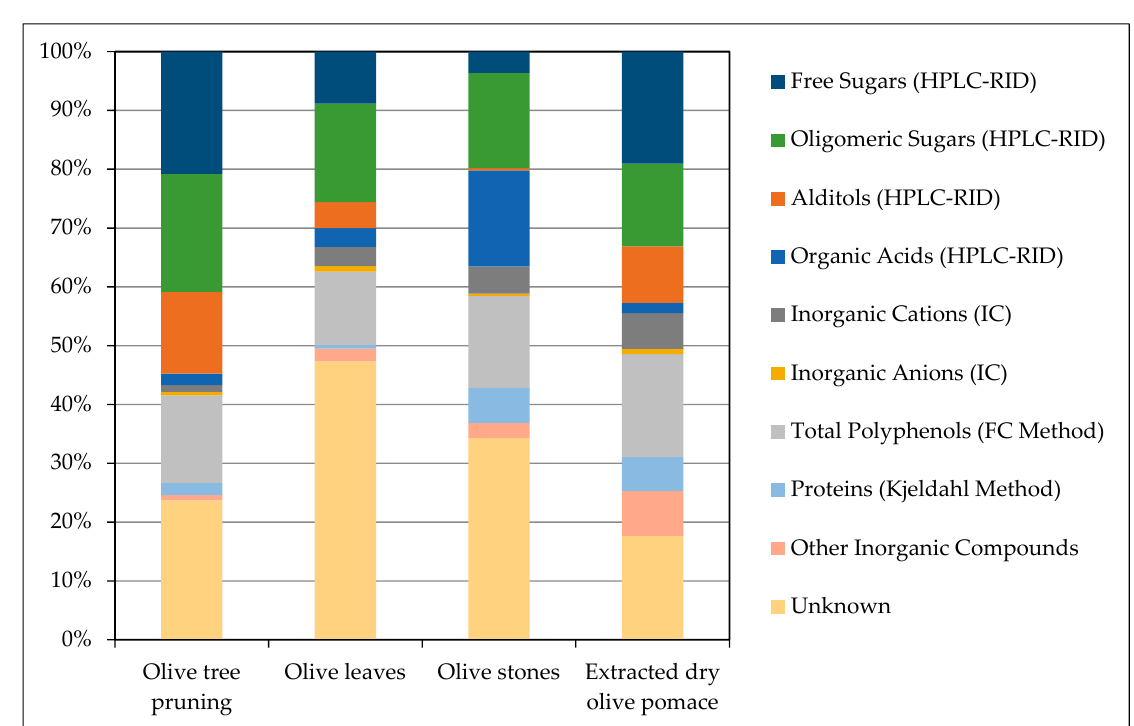
Figure 2. Overall composition of aqueous extractives for each olive by-product. HPLC-RID: High performance liquid chromatography-refractive index detector; IC: Ionic chromatography; FC: Folin-Ciocalteu